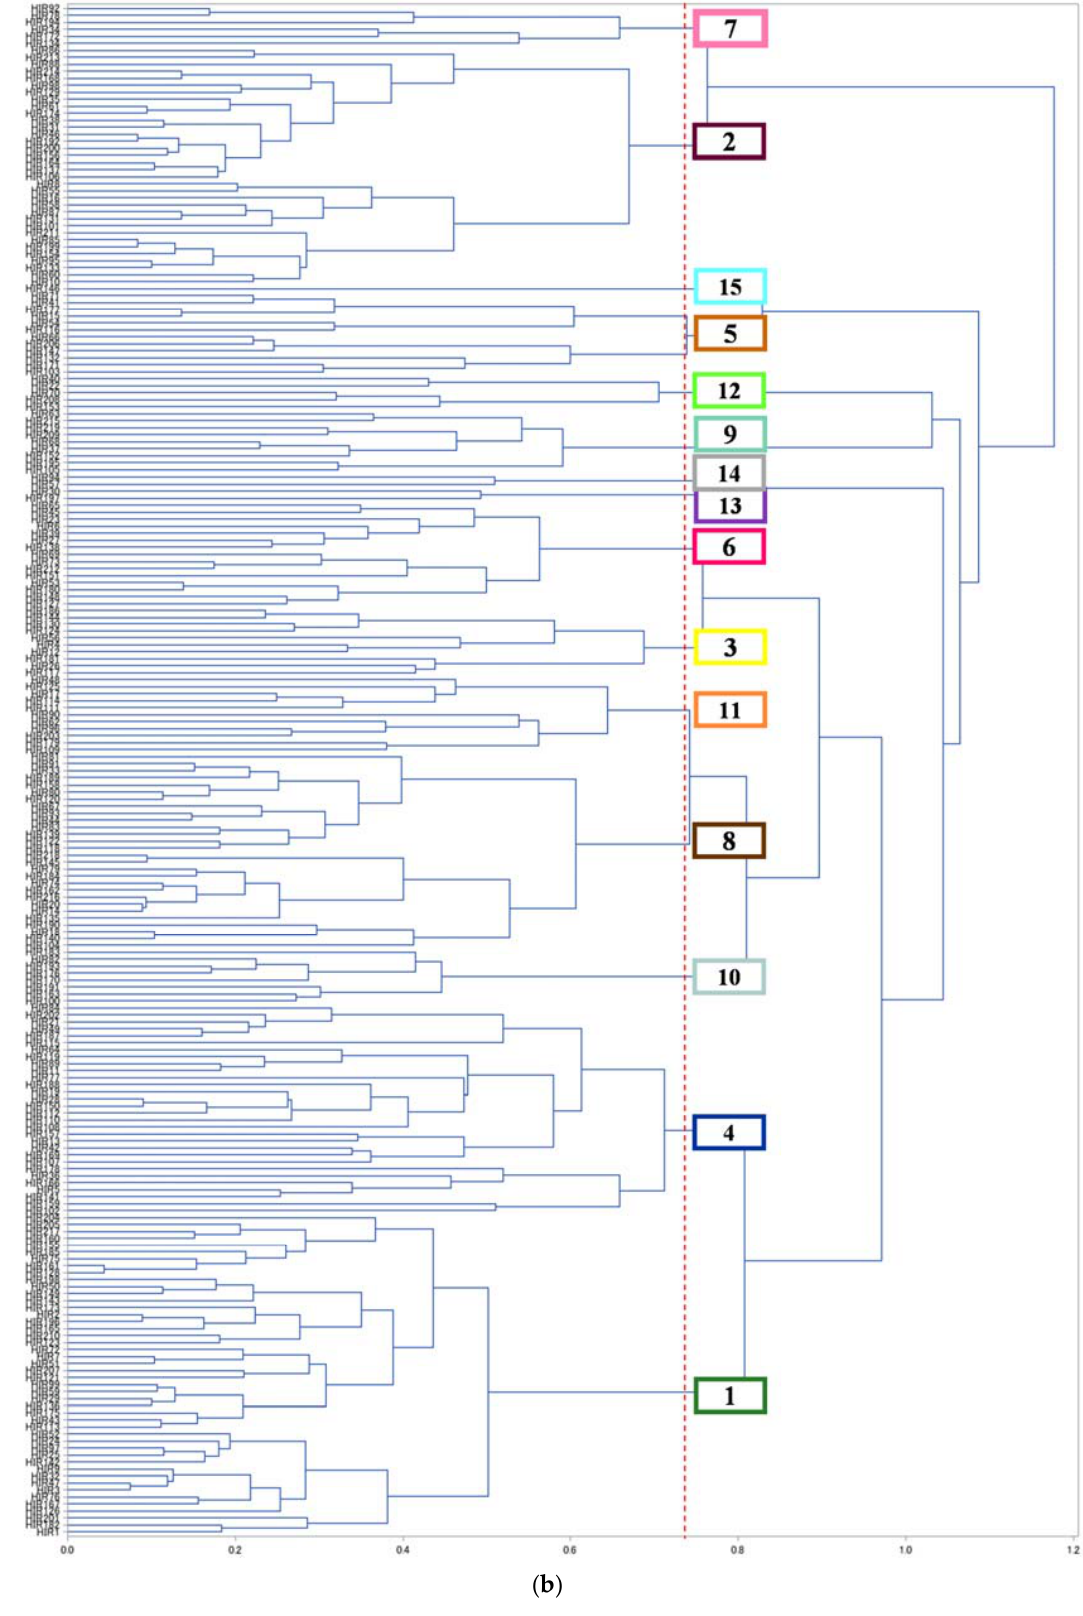
Figure A1. Dendograms of HIR clustering. ( a ) Morning commute HIRs; ( b ) Evening commute HIRs.